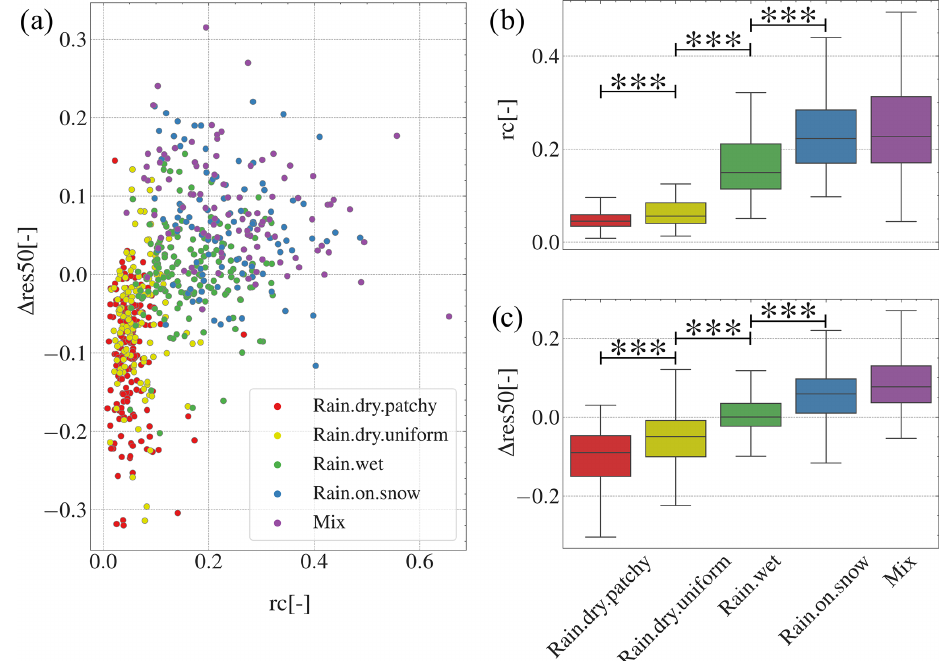
Figure 7. (a) Relationship between (cid:49) res50 for each catchment and event type and median runoff coefficient (rc); runoff coefficient is not defined for No.event. (b) Variability of runoff coefficients (rc) for each event type and (c) median residuals for each event type. Significance of median differences between adjacent boxplots was estimated using the Kruskal–Wallis test (displayed as ∗∗∗ for p <